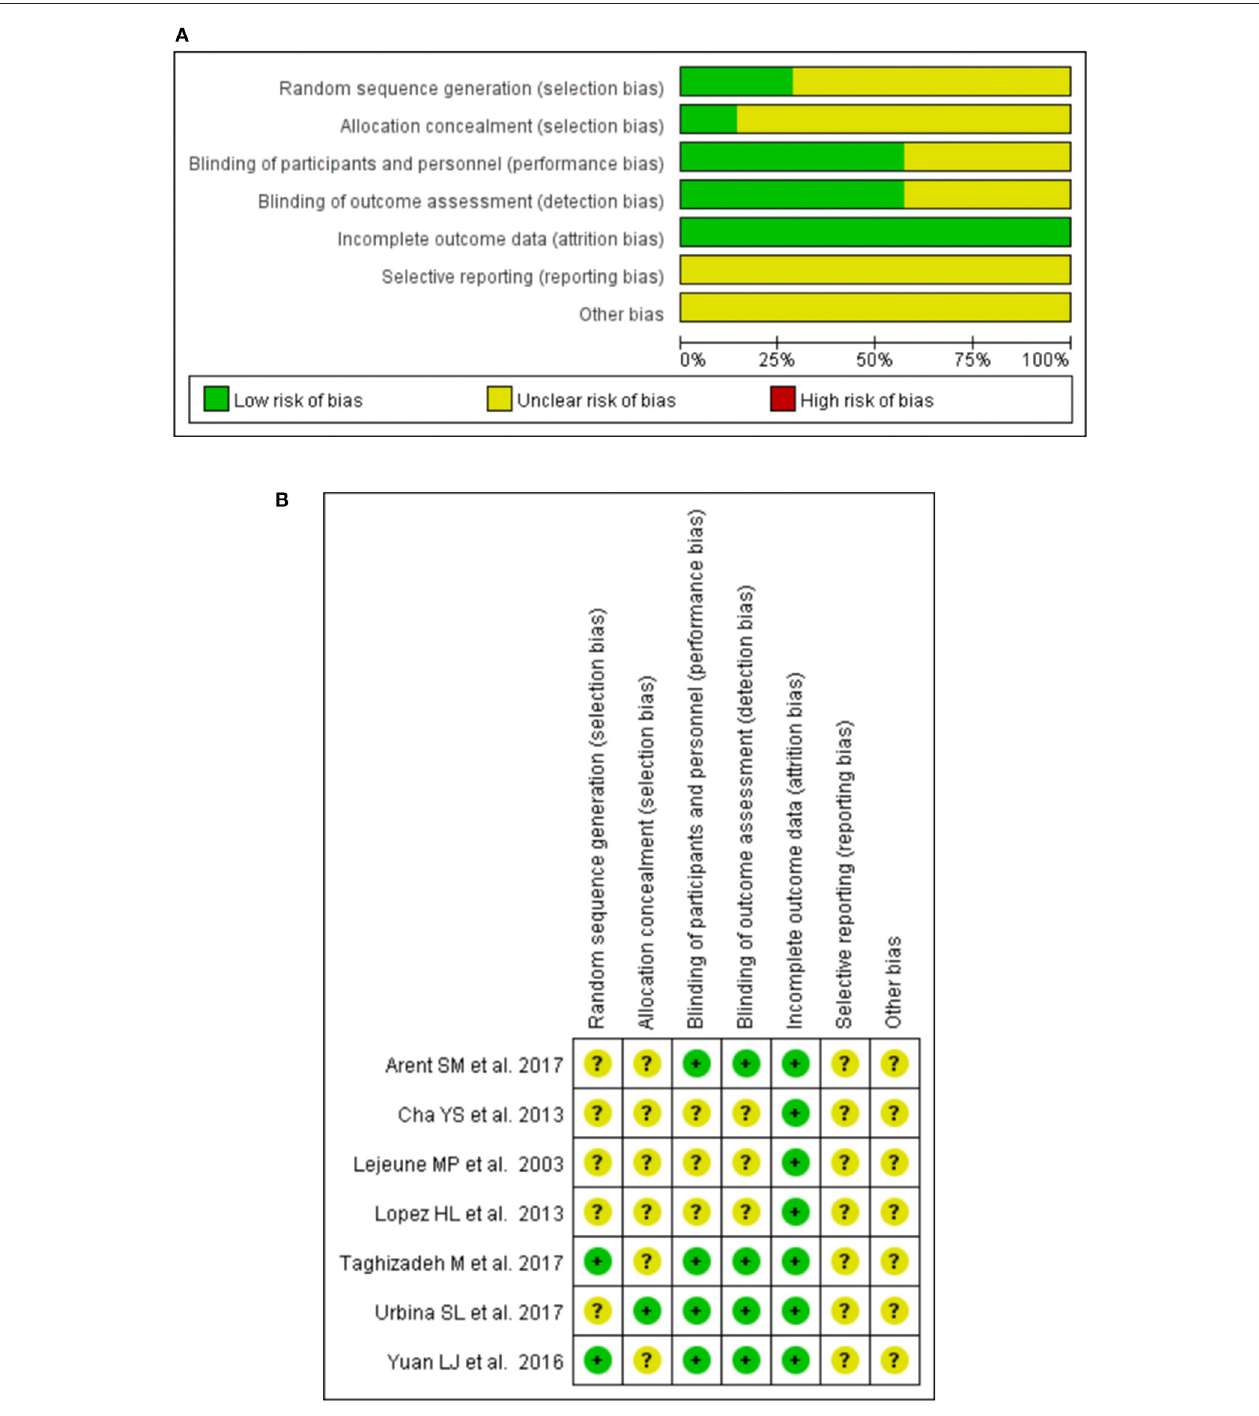
FIGURE 2 | Graph of bias risk assessment for included studies by the Cochrane Collaboration’s tool. (A) Risk of bias graph. (B) Risk of bias